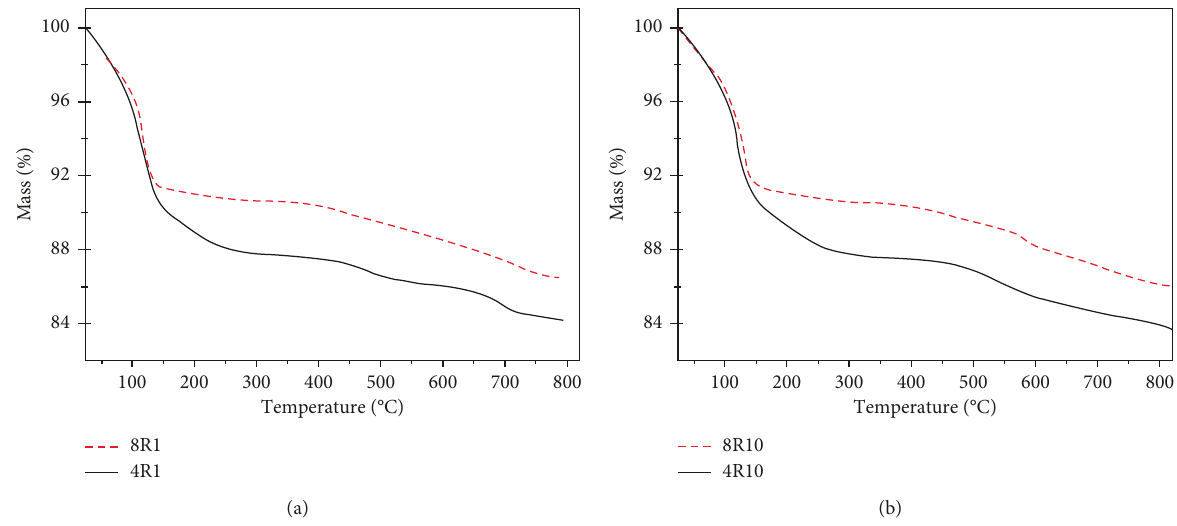
Figure 2: Thermograms for the materials synthesized at a heating rate of (a) 1 ° C/min and (b) 10 ° C/min.